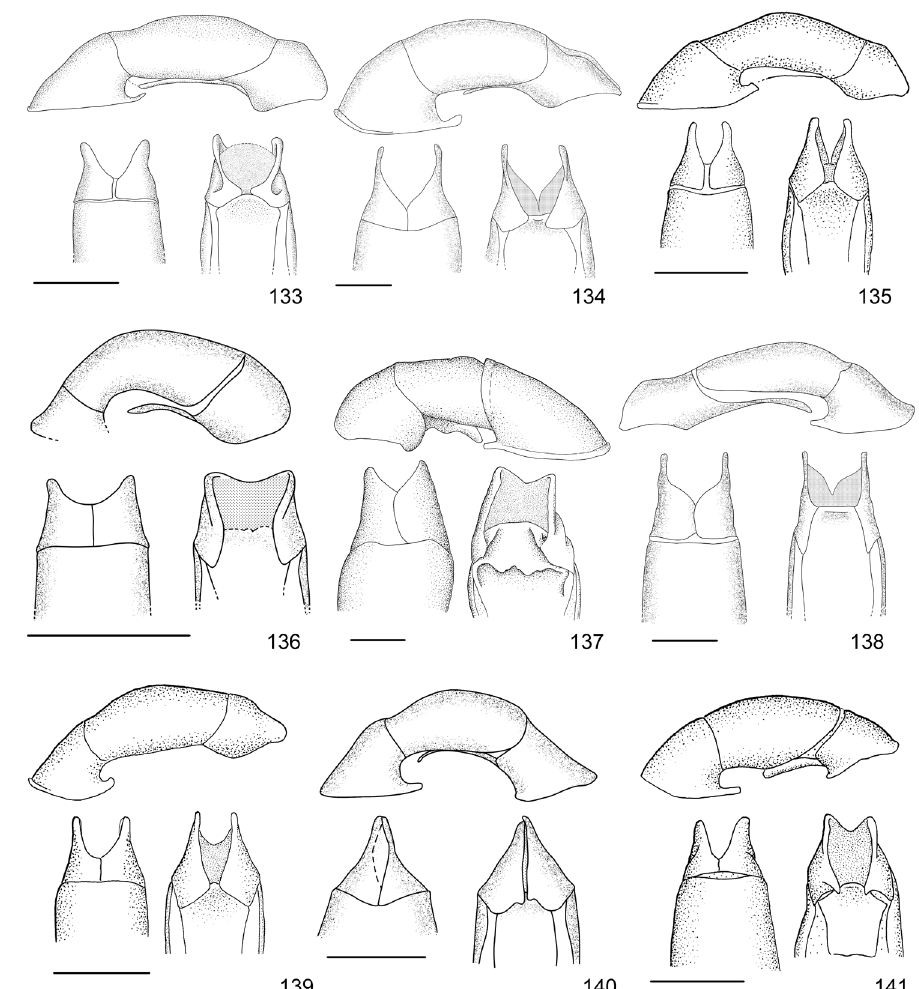
Figures 133–141. Shape of aedeagus, lateral view (top), dorsal view (bottom left), ventral view (bot- tom right). 133 Anomala divisa (Cinco esquinas de Carrizal, Alajuela, MNCR) 134 A. estrella (Estación La Casona, Puntarenas, MNCR) 135 A. eucoma (San José, San José, MUCR) 136 A. eulissa (Estación Biológica La Selva, Heredia, MNCR) 137 A. eusticta (Estación La Casona, Puntarenas, MNCR) 138 A. ferrea (Las Cruces, Puntarenas, MNCR) 139 A. flavacoma (Estación Cabro Muco, Guanacaste, CEUA) 140 A. foraminosa (Estación Hitoy Cerere, Limón, MNCR) 141 A. globulata (Macizo de la Muerte, Cartago, MNCR). Scale bars: 1 mm. Fig. 139 from Filippini et al. (2013), Fig. 138 from Filippini et al. (2014); Fig. 134 from Filippini et al. (2015b); Fig. 133 from Filippini et al. (2015c); Figs 137, 141 from Filippini et al.